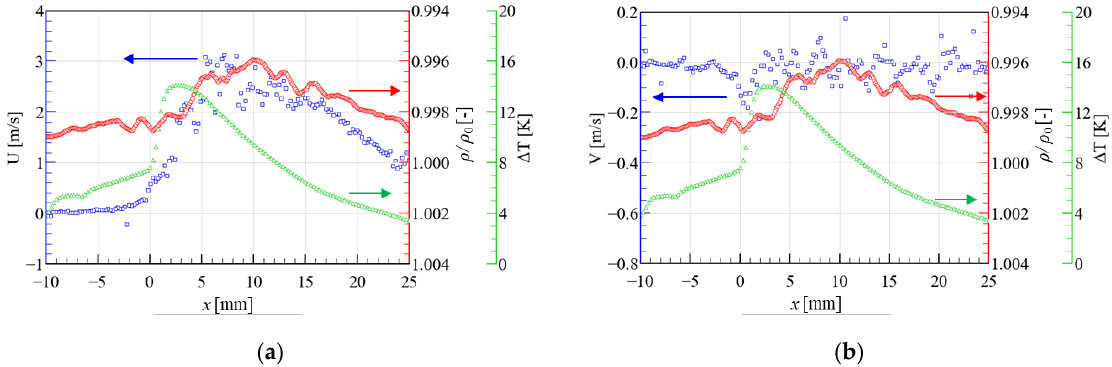
Figure 10. x -profiles of the flow, density field, and surface temperature of the plate-PA: ( a ) x -profiles of the horizontal velocity, density, and temperature; ( b ) x -profiles of the vertical velocity, density, and temperature. The blue marker shows the horizontal and vertical velocity. The red and green markers show the density and surface temperature, respectively.